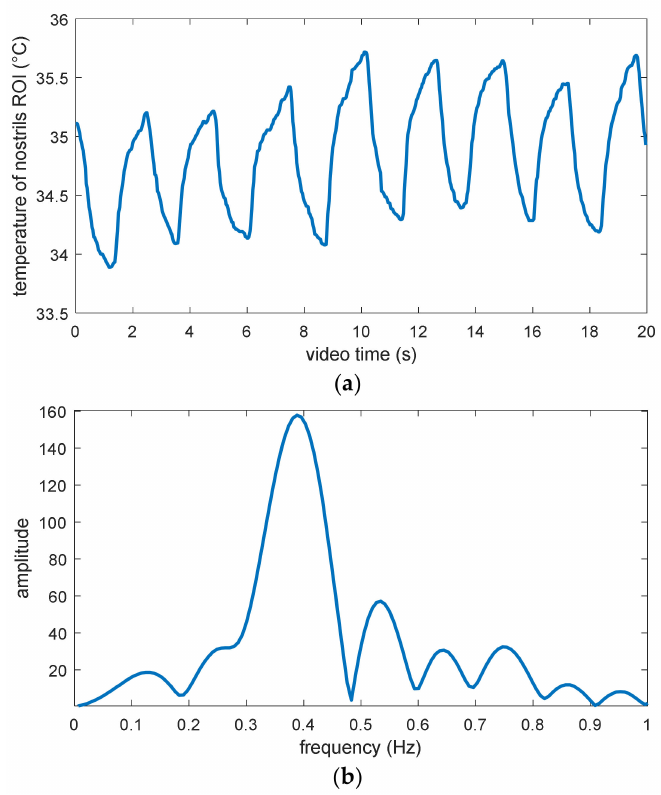
Figure 9. Estimation of respiration rate from the nostrils’ ROI: ( a ) Temporal temperature signal, ( b ) power density spectrum calculated from the respiration